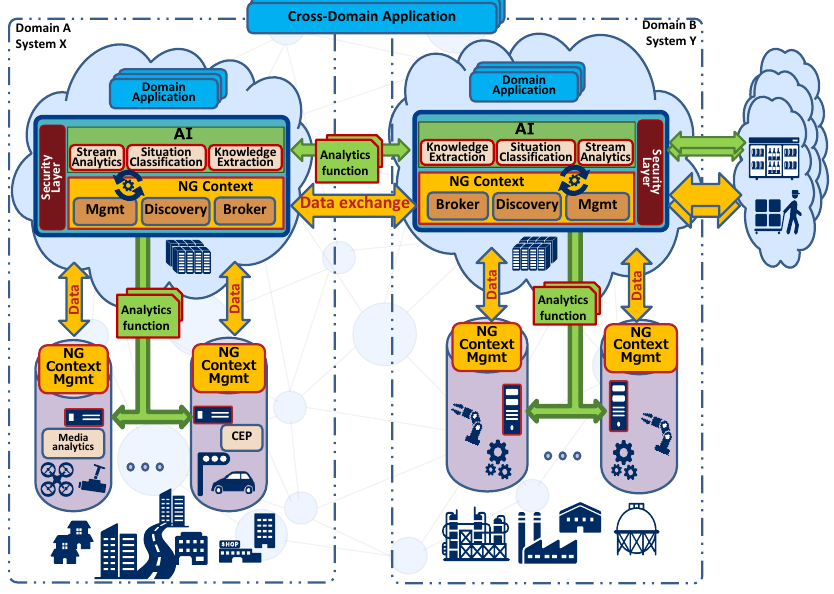
Figure 5. Resources and context management